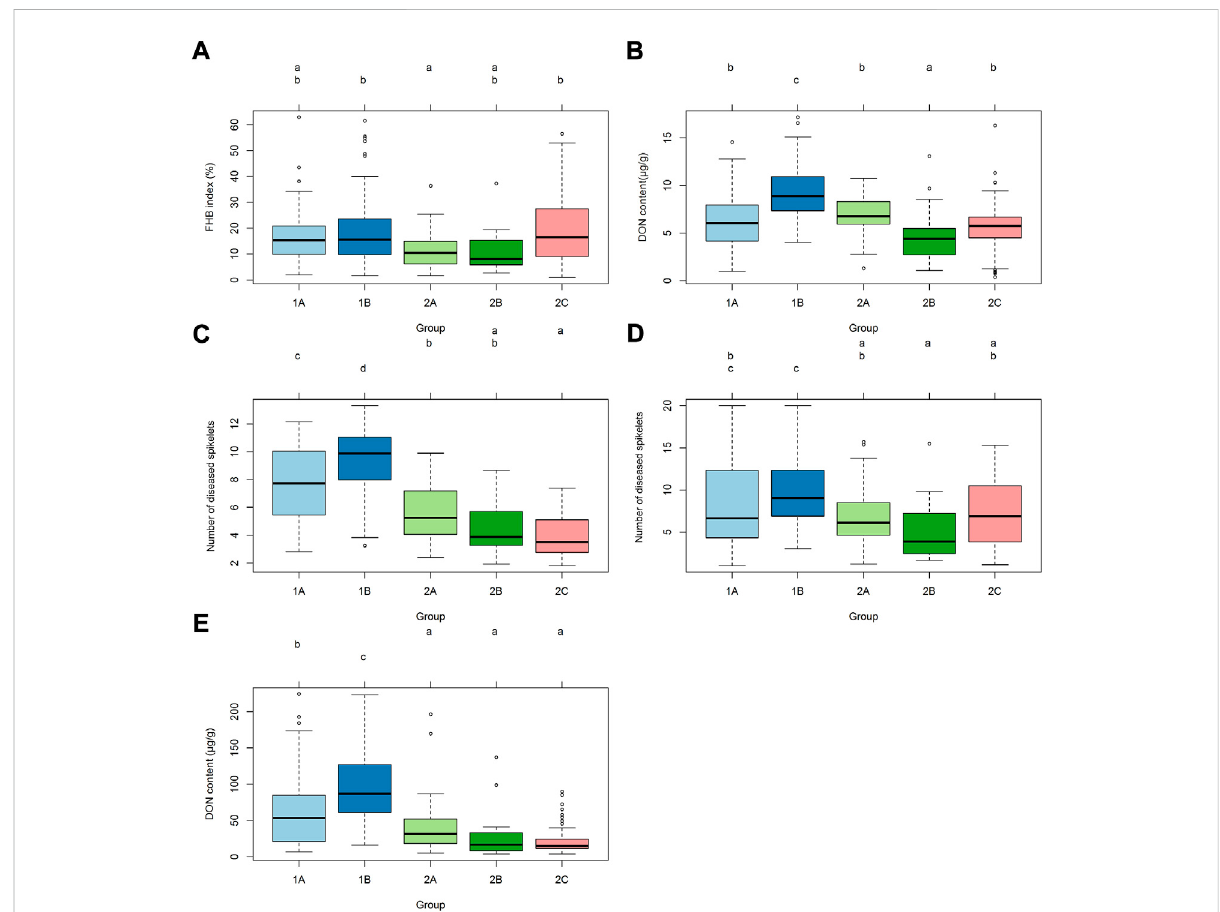
FIGURE 2 Distributions of FHB index, number of diseased spikelets and DON content among different groups. (A) Distribution of mean data of FHB index using spray inoculation among different groups in 2018 and 2019 in Mexico. (B) Distribution of mean data of DON content using spray inoculation among different groups in 2018 and 2019 in Mexico. (C) Distribution of mean data of FHB severity using point inoculation among different groups in 2018, 2019 and 2020 in China. (D) Distribution of mean data of FHB severity using spawn inoculation among different groups in 2018 and 2019 in China. (E) Distribution of mean data of DON content in grains using point inoculation among different groups in 2018, 2019 and 2020 in